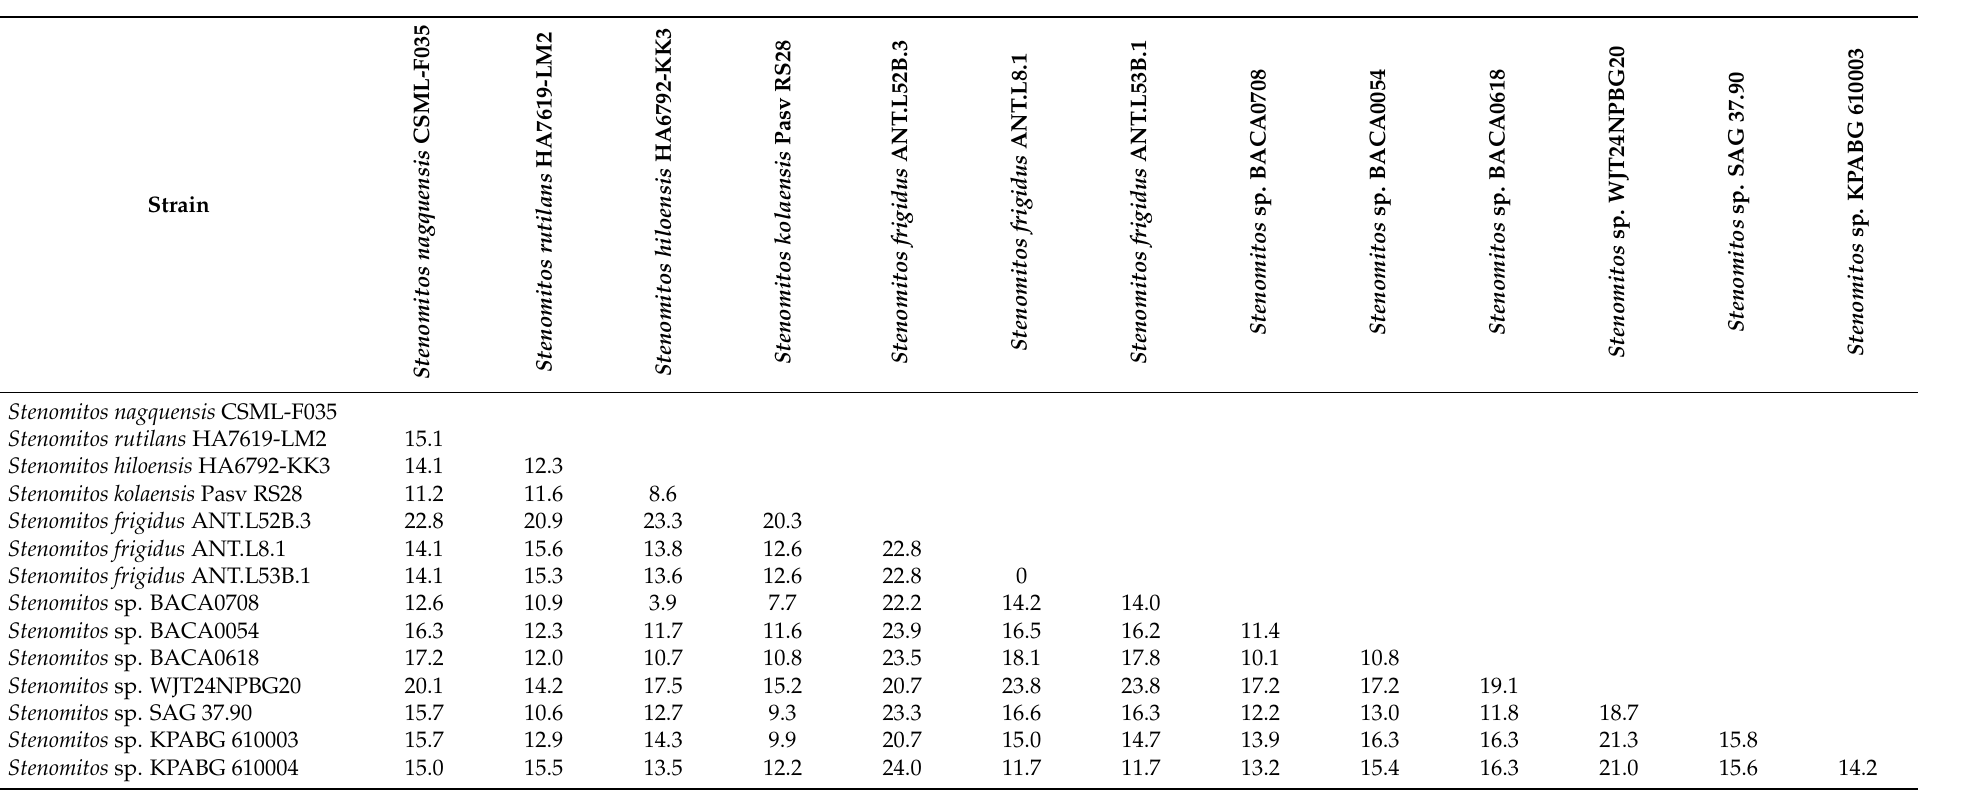
Table 1. Percentage dissimilarity based on 16S–23S ITS sequences for operons containing both tRNA genes among Stenomitos nagquensis sp. nov. and its closely related